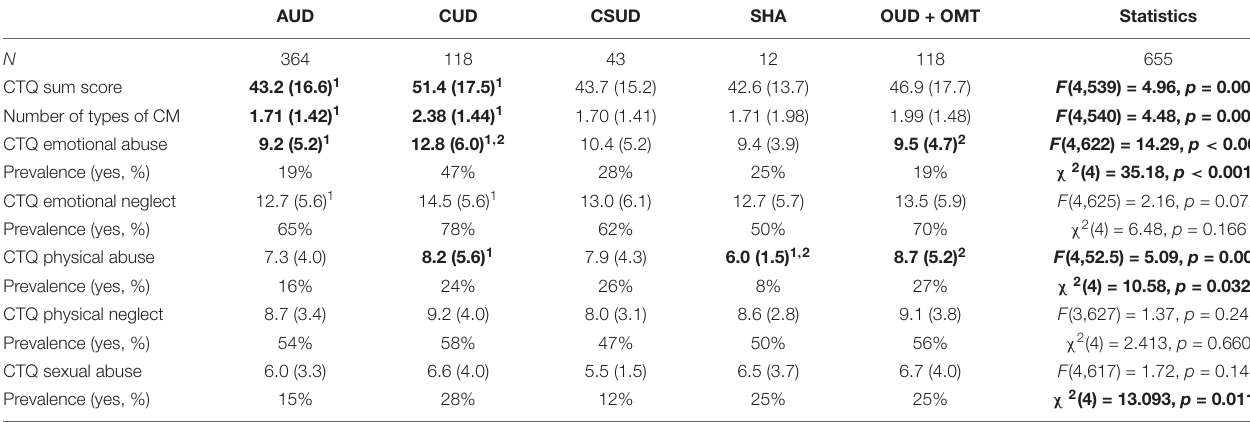
TABLE 3 | Severity of childhood